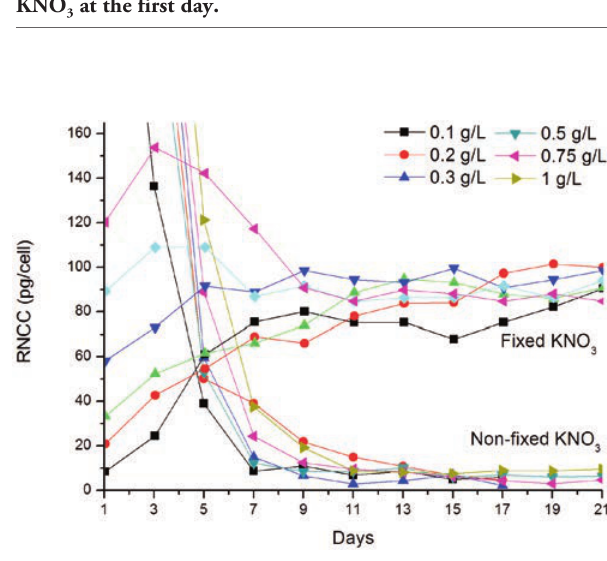
, multiple supplement- 3 , one-time adding 3